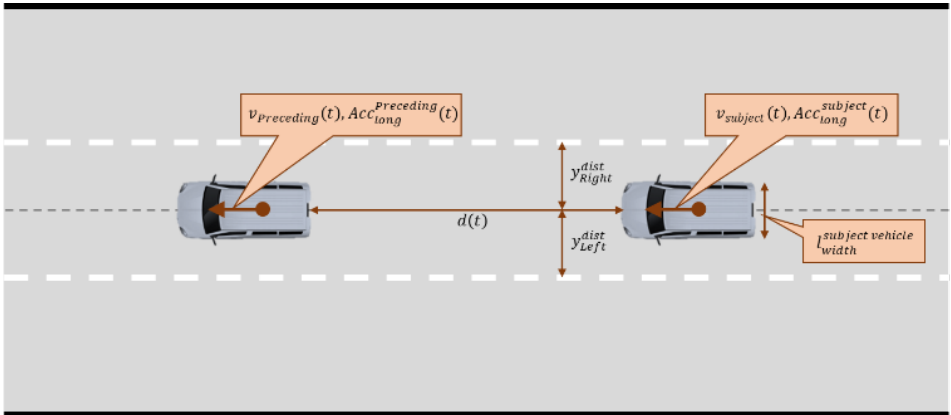
Figure 2. Explanation of the variables used to calculate the safety indicators.